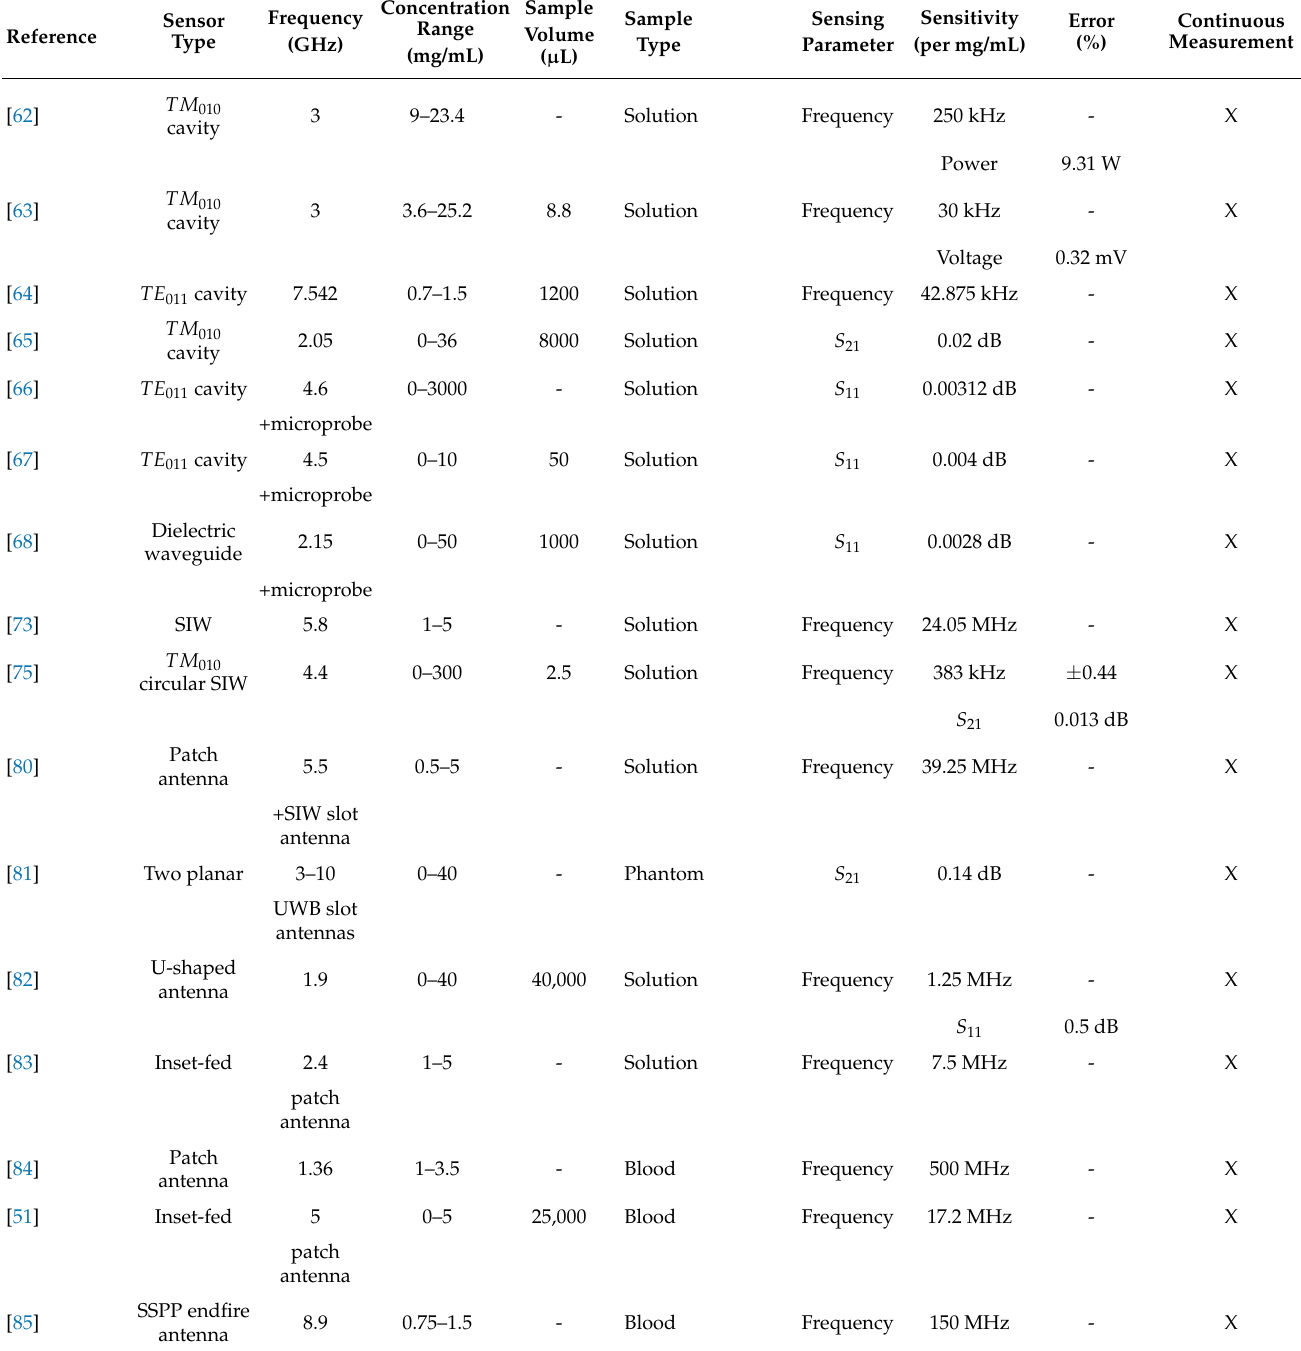
Table 3. Radio-frequency glucose